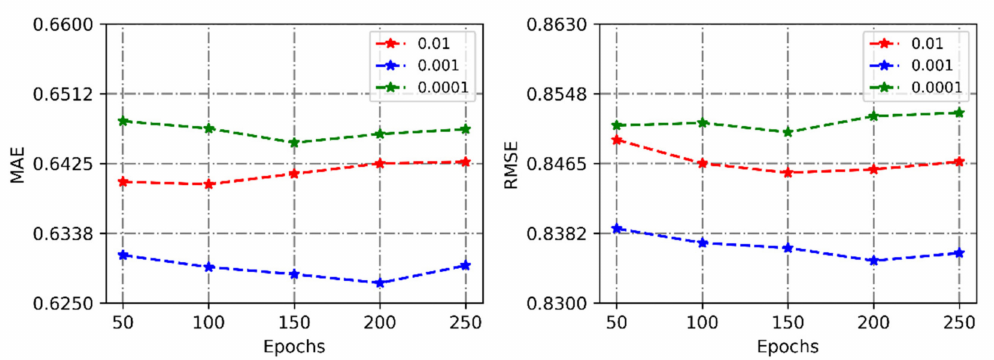
Figure 6. Comparison between Learning Rates.